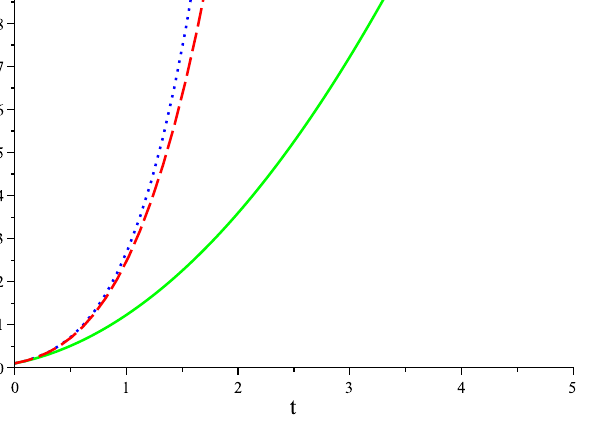
Fig. 3 The behavior of R ( t ) with respect to t for w = − 3 / 4, n = 5 and α = − 1 , 1 , 0 from up to down,